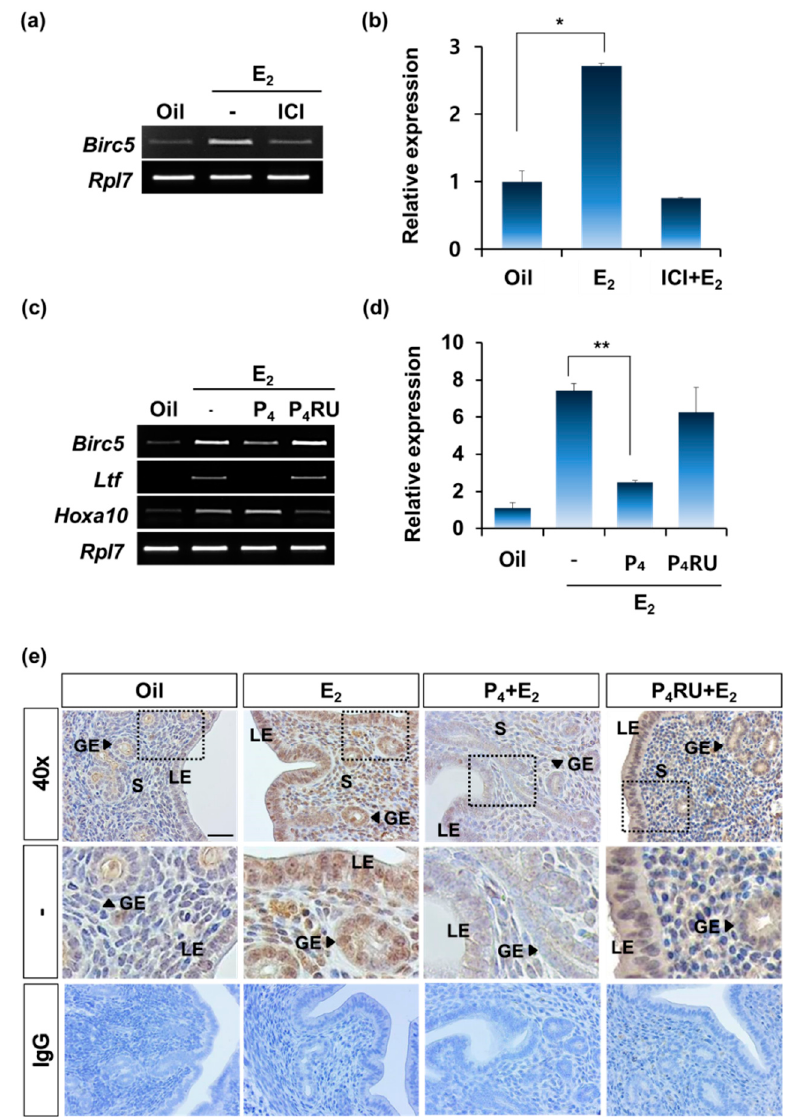
Figure 5. Regulation of Birc5 expression via estrogen and progesterone receptors. ( a ) Estrogen receptor (ER) antagonist, ICI 182,780 (ICI) was applied before E 2 treatment and the mice were sacrificed at 24 h after the E 2 treatment. Birc5 expression was analyzed by RT-PCR (each group n = 4). ( b ) qRT-PCR was used to quantify the relative level of Birc5 expression. The criterion of relative expression change was based on the value at oil treatment in OVX mice. Sesame oil, Oil; ICI 182,780 (ICI); and estrogen, ICI+E 2 . *, p -value ( p < 0.01). ( c ) RT-PCR analysis of Birc5 expression in the uterus of OVX mice after treatment with E 2 and co-treatment with E 2 + P 4 or RU486 + E 2 + P 4 . (each group n = 4). Lactoferrin ( Ltf ) and Homeobox A10 ( Hoxa10 ) were used to confirm the appropriate hormone response. Ribosomal protein L7 ( Rpl7 ) gene was used for internal control. ( d ) qRT-PCR showed the relative fold changes in Birc5 expression. The criterion of relative expression change was based on the value at oil treatment in OVX mice. **, p -value ( p < 0.01). ( e ) Immunohistochemical analysis of BIRC5 in uteri of OVX mice treated with E 2 , P 4 + E 2 or RU486 + E 2 + P 4 (P 4 RU + E 2 ).